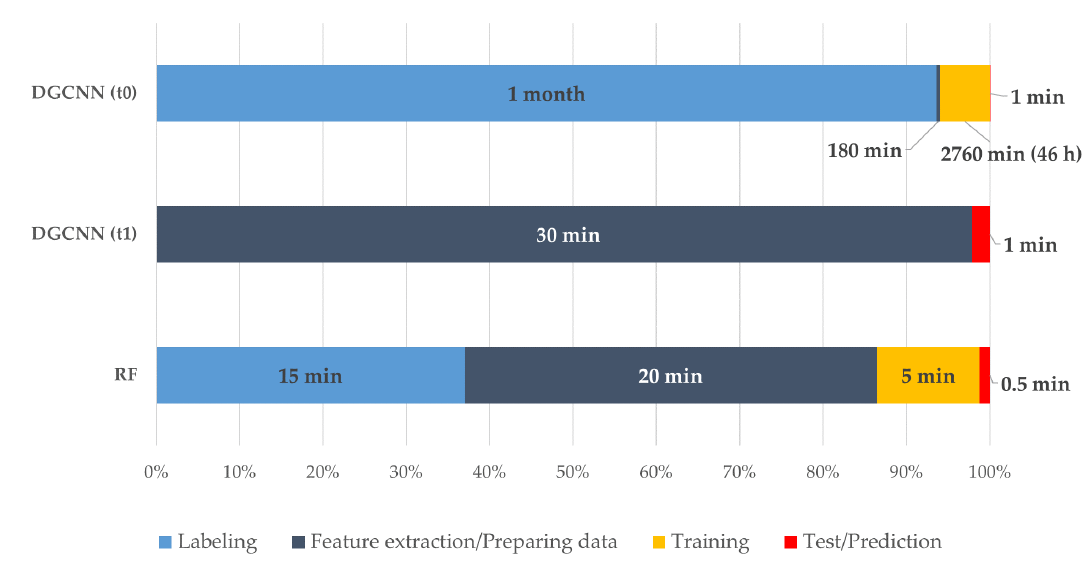
Figure 11. Normalised comparison of times required for the different scenarios test. NN (t0) represents the first scenario in which the whole dataset has been manually labeled and the DGCNN-based methods have been trained on all the scenes. NN (t1), on the other hand, represents the next scenario in which it is possible to use the weights from the pre-trained neural network and conduct directly the data preparation (feature extraction, scaling, blocks creation, subsampling...) and the final test for the